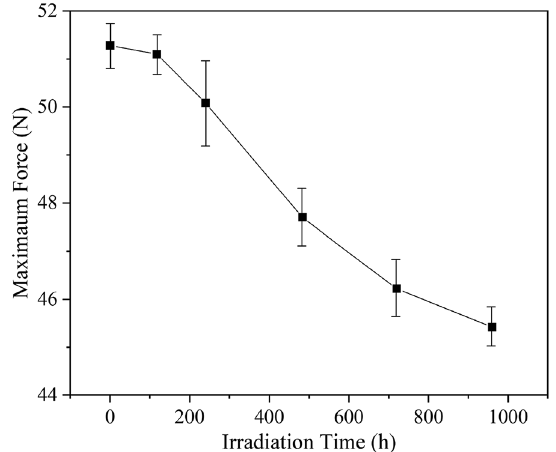
Figure 4 The maximum force of Sn37Pb solder joints at various irradiation time in the impact test [17]